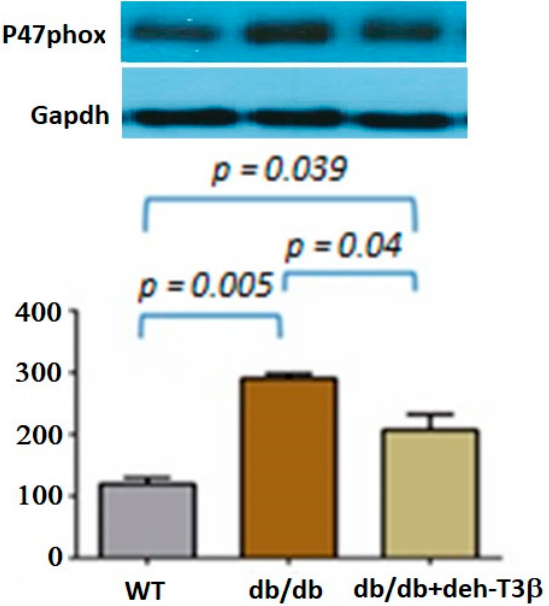
Figure 8. Western blot analysis of P47-phox expression in wt and db/db mice heart. Db/db mice were fed with deh-T3 β mixed with the diet for two months.